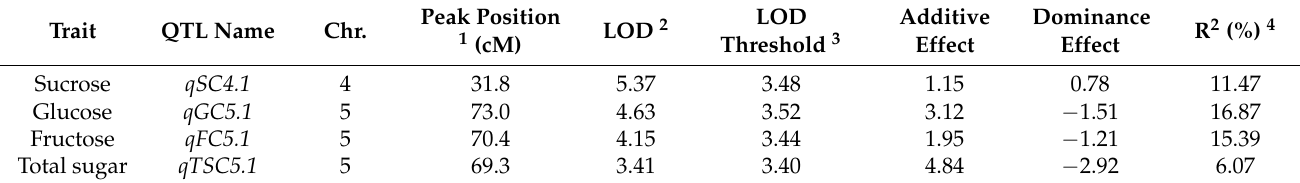
Table 4. Summary of QTLs for sugar content detected in an F 2 population of ‘16P118 × Sweet Green’.